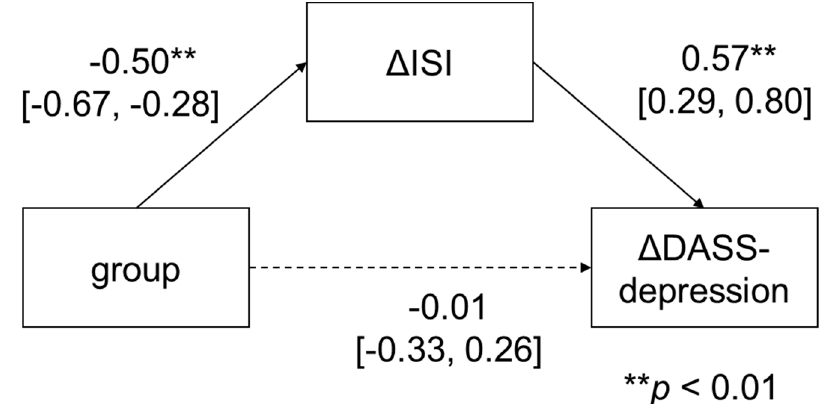
Figure 2. Mediation analysis of DASS-depression .